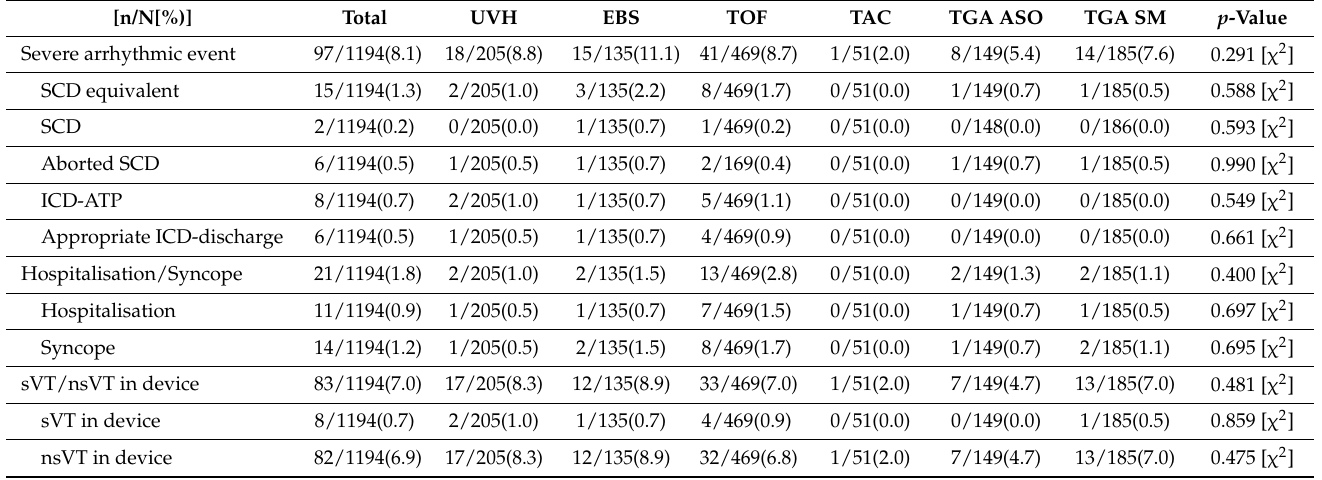
Table 2. Occurrence of severe arrhythmic events (total and separated in CHD